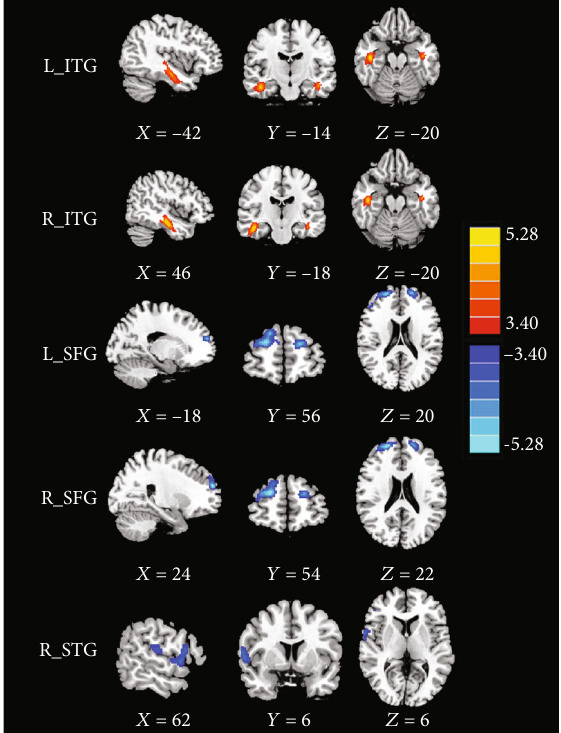
Figure 3: The CBF connectivity maps of six ROIs from the mTBI patients and the HC were displayed, including the bilateral inferior temporal gyrus (ITG), bilateral superior frontal gyrus (SFG), right middle frontal gyrus (MFG), and right cerebellum posterior lobe (CPL).